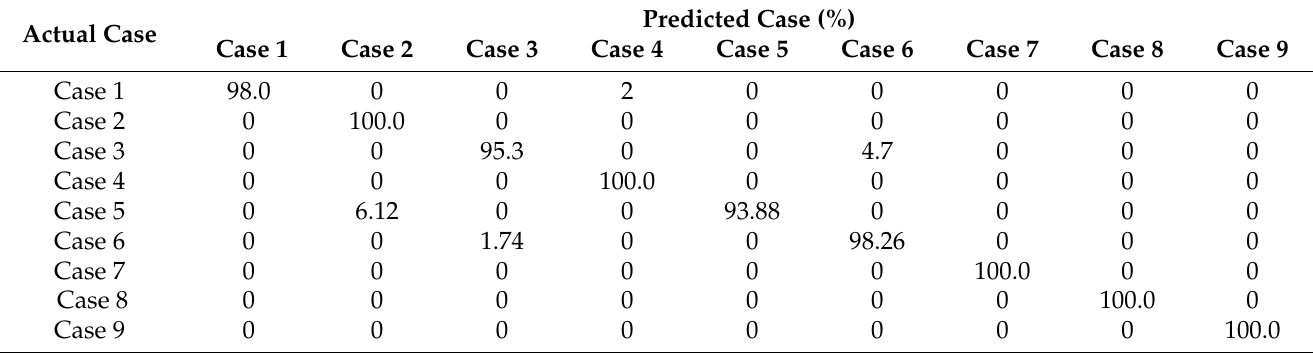
Figure 9. Instantaneous target identification results: Cases 1 to 9. Table 4. Confusion Matrix for Cases 1 to